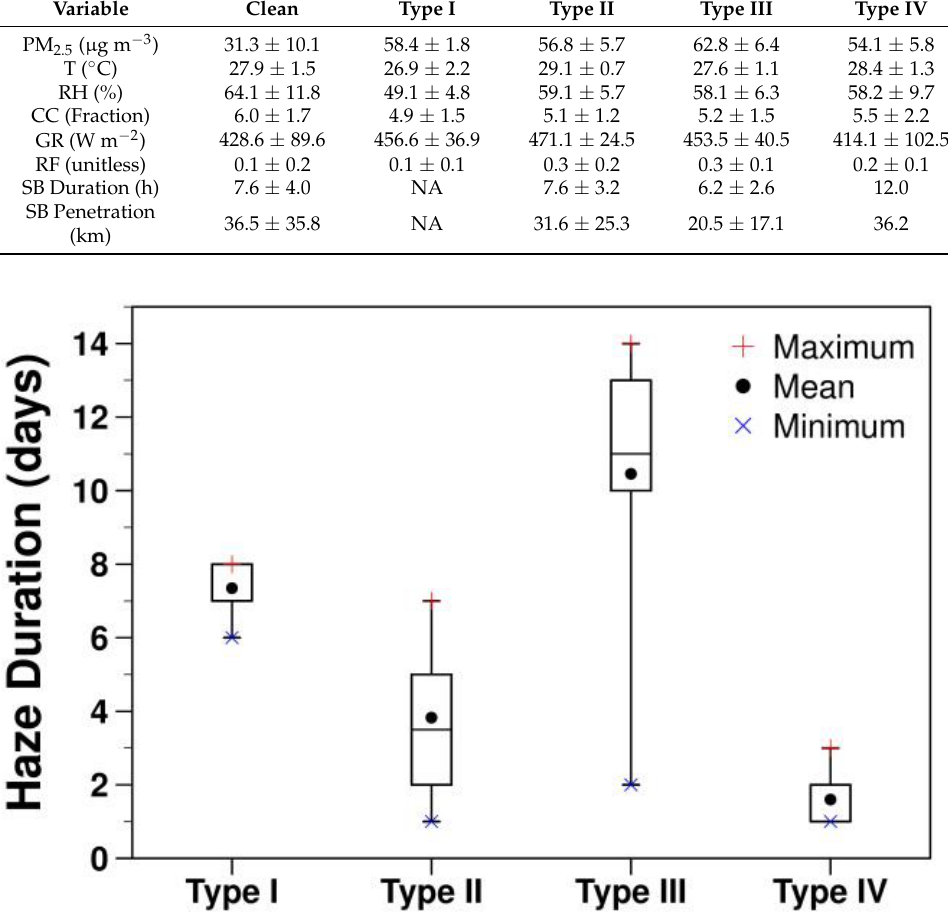
Figure 4. Haze duration by haze type.